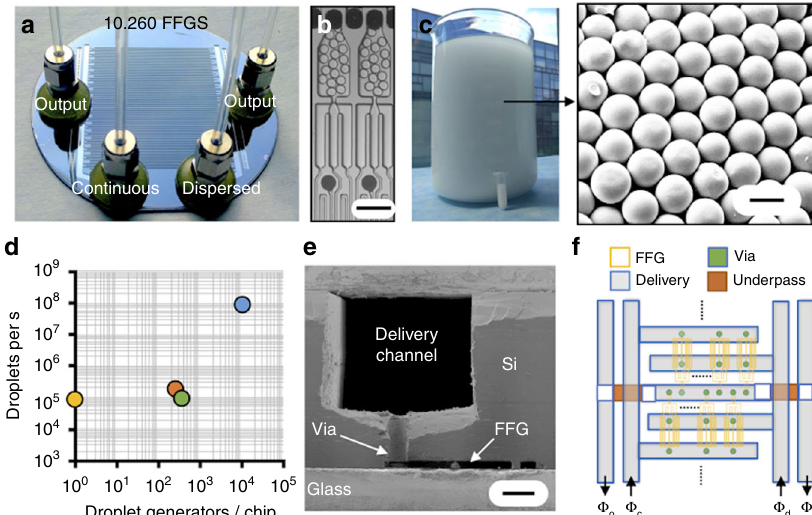
Fig. 1 All silicon and glass VLSDI for high-throughput microparticle production. a A photograph of the VLSDI chip, which consists of 10,260 (285 × 36) fl ow-focusing droplet generators (FFGs). b An optical micrograph of two individual droplet generators producing droplets. Scale bar: 140 µ m. c Organic phase in water emulsion (3.5 L) generated from VLSDI in 30 min on a chip operated at a dispersed fl ow rate Φ d = 2.09 L h − 1 (10 wt% polycaprolactone in dichloromethane) and a continuous fl ow rate Φ c = 5 L h − 1 (2 wt% polyvinylalcohol in water). The inset shows an SEM (scanning electron microscope) image of polycaprolactone microparticles obtained after evaporation of dichloromethane. Scale bar: 8 µ m. The 2 mL tube represents the emulsion collected from a conventional micro fl uidic droplet generator in 1 h. d Moore ’ s Law of polymer microparticle generation. Yellow 11 , green 19 , orange 12 , blue: this work. e An SEM micrograph of the cross section of the VLSDI chip. Scale bar: 90 µ m. f The ladder design architecture that our chip uses to incorporate 10,260 parallel droplet generators. Φ o emulsion output, Φ c , Φ d supply channels for continuous and dispersed